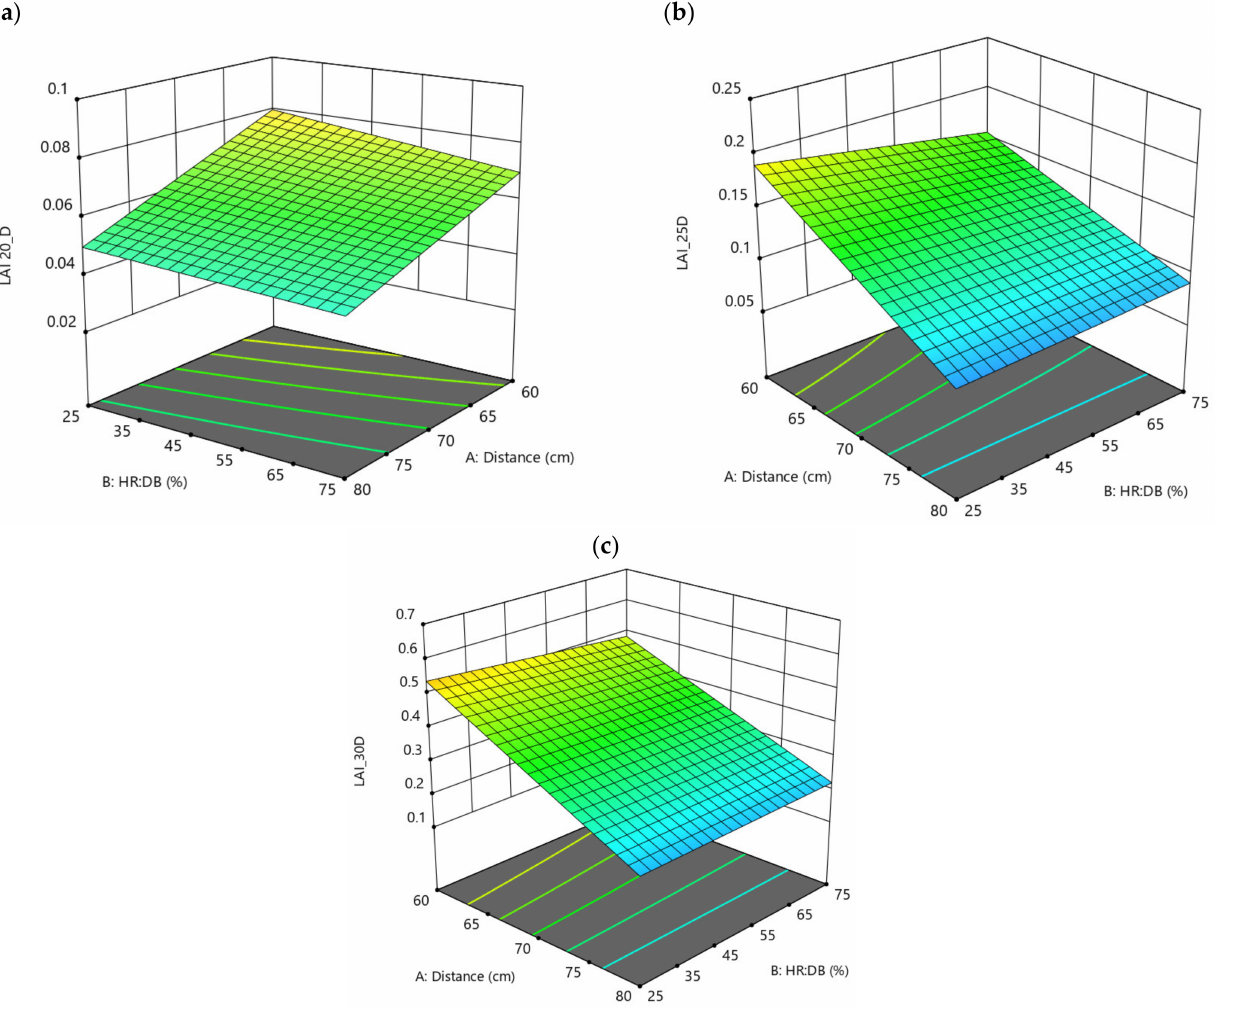
Figure 9. Contour plots of the models related to the property LAI: ( a ) LAI_20D; ( b ) LAI_25D; ( c )